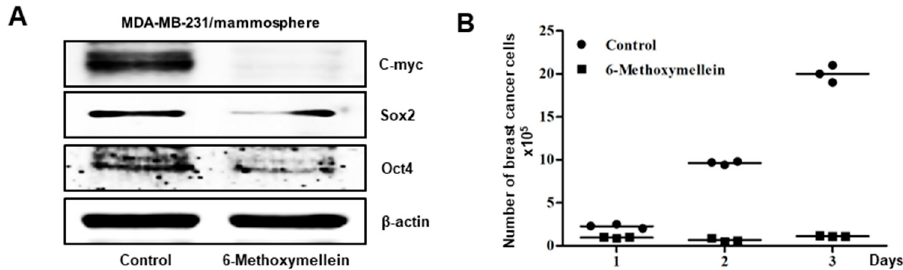
6-Methoxymellein suppresses the protein expression of CSC markers and inhibits mammosphere. ( A ) Westernblot analysis of the c-Myc, Sox-2 and Oct4 proteins of mammospheres treated with 6-methoxymellein for 2 days. ( B ) 6-Methoxymellein inhibits mammosphere